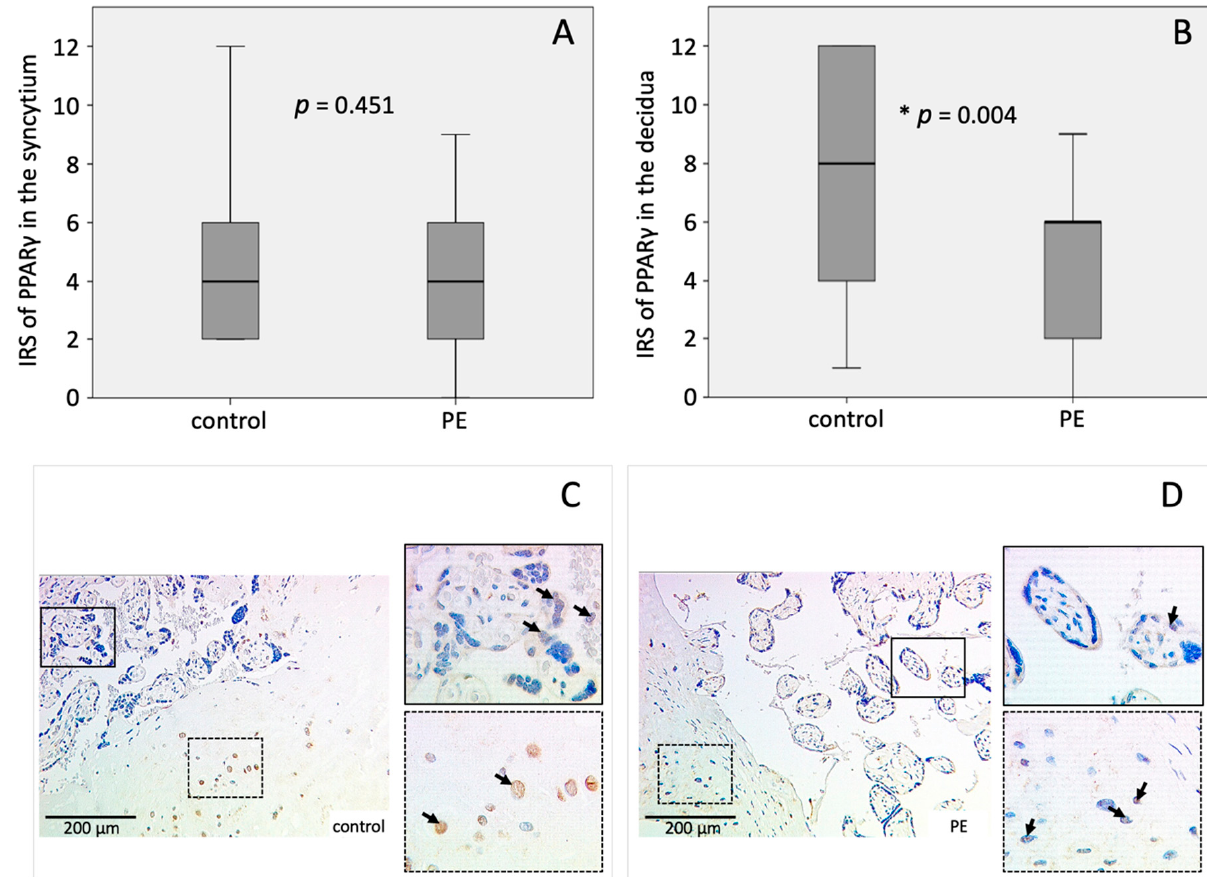
Figure 1. Immunohistochemical staining results of PPAR γ . Boxplots of the IRS in the ( A ) syncytiotrophoblast and ( B ) the decidua as mean ± SD; p -values were calculated with Mann–Withney-U-Test; representative immunohistochemical images of PPAR γ in controls ( C ) and PE placentas ( D ) were chosen, continuous line: syncytium, dotted line: decidua. IRS of control placenta: syncytiotrophoblast = 4, decidua = 4; IRS of PE placenta: syncytiotrophoblast = 4, decidua = 2. The respective p -value indicates, if the IRS of controls and PE differ significantly and was calculated using the